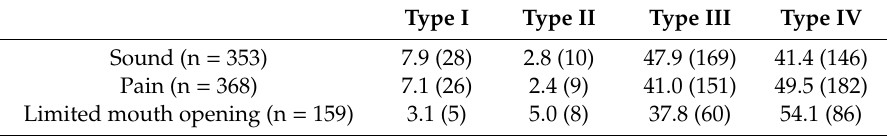
Table 1. Type of CBCT and MRI findings according to the clinical symptoms % (number).